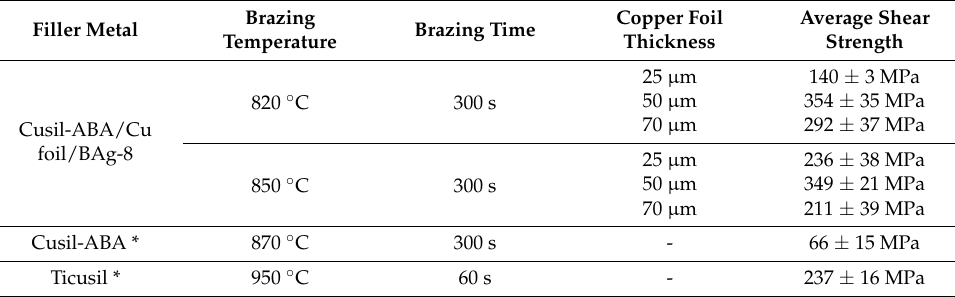
Table 5. Average shear strengths of infrared brazed Ti 50 Ni 50 SMA and 316L SS joints.